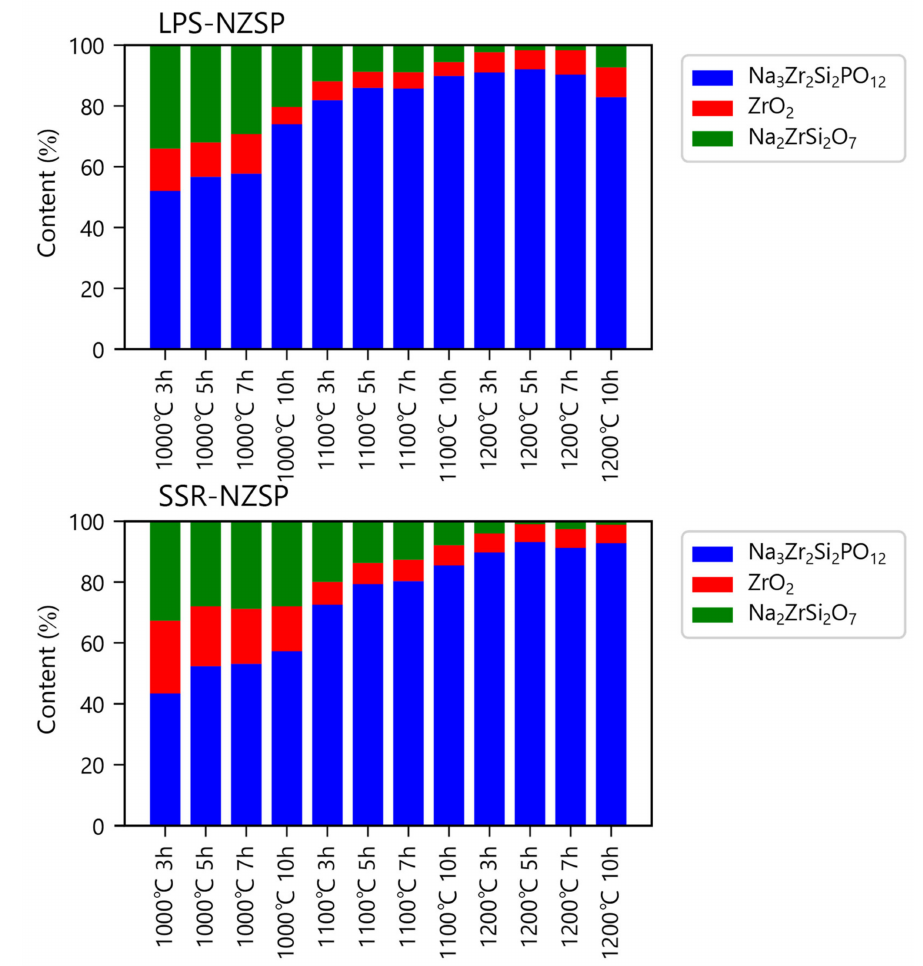
Figure 4. Content of formed phases determined by Rietveld fitting.